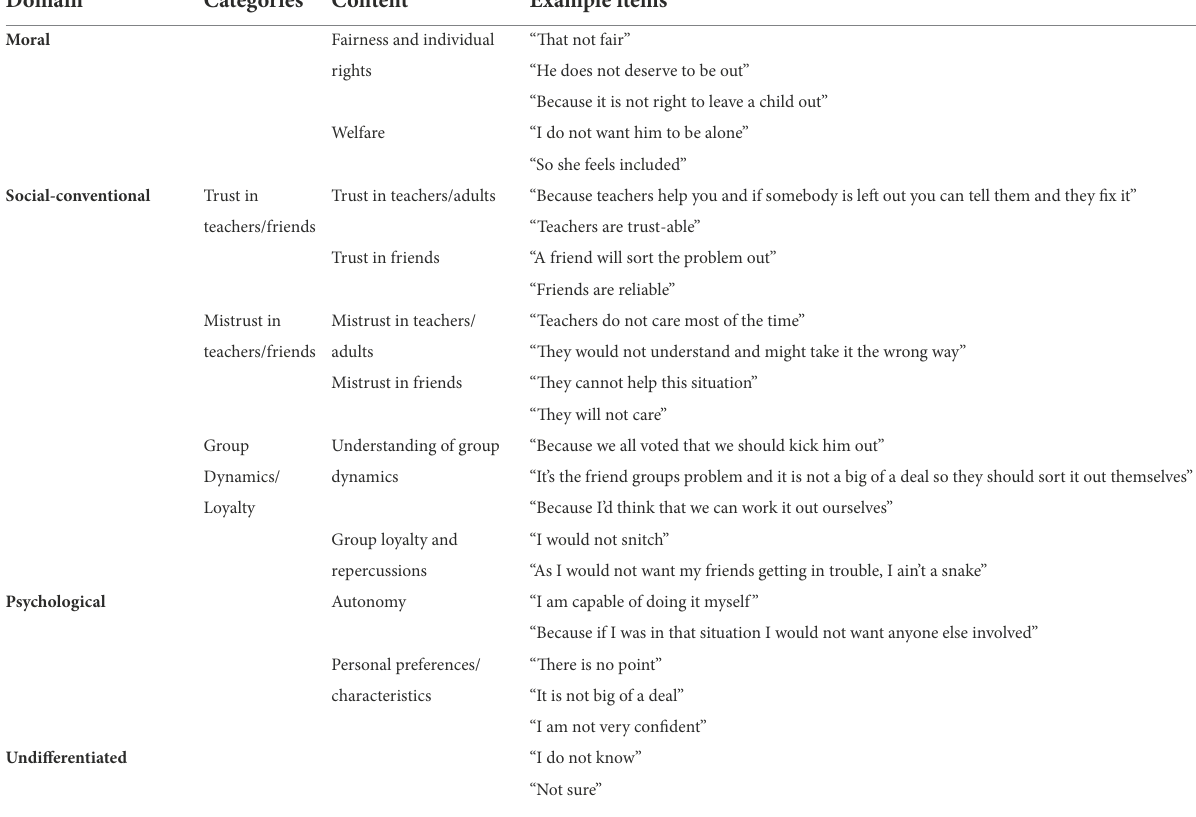
TABLE 2 Coding domains, categories, content, and example items.